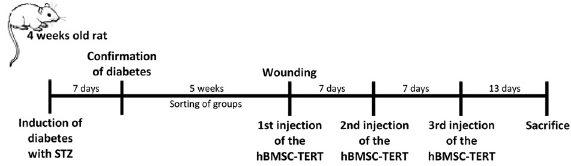
Figure 1. Experimental groups and study design. Five weeks after the con fi rmation of diabetes, skin lesions were performed and, immediately afterwards, an intracutaneous infusion of phosphate buffer solution (control group and diabetic rats wounded) or 1 (cid:1) 10 6 human bone marrow mesenchymal stem cells immortalized by the expression of telomerase (hBMSC- TERT) (C-TERT and DM-TERT groups) was performed. Fasting glycemia was determined weekly and photographic assessments of the wounds were performed on days 0, 3, 7, 14, and 21 days after the fi rst infusion. STZ: streptozotocin.